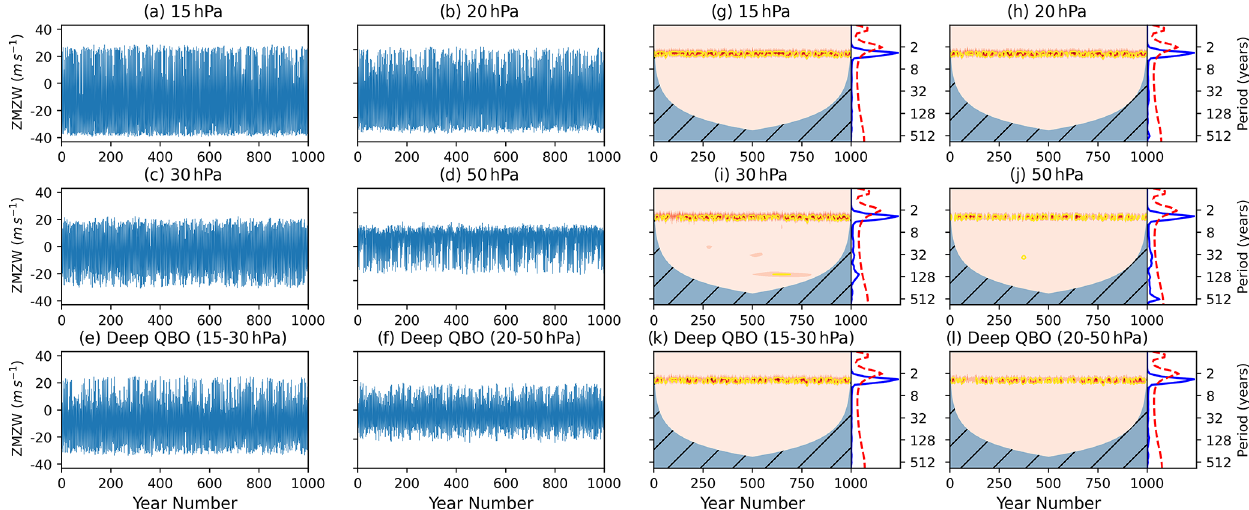
Figure 10. (a–f) September–November mean ZMZW averaged between 5 ◦ S–5 ◦ N latitude on different pressure levels (a–e) and the deep metric averaged between 15–30hPa (f) . (g–l) Wavelet power spectra for each time series shown in panels (a–c) . Shading represents wavelet power with a colour scale the same as that seen in Fig. 6, and yellow contours indicate regions of significant power ( > 95% confidence interval) compared to a background AR1 process.